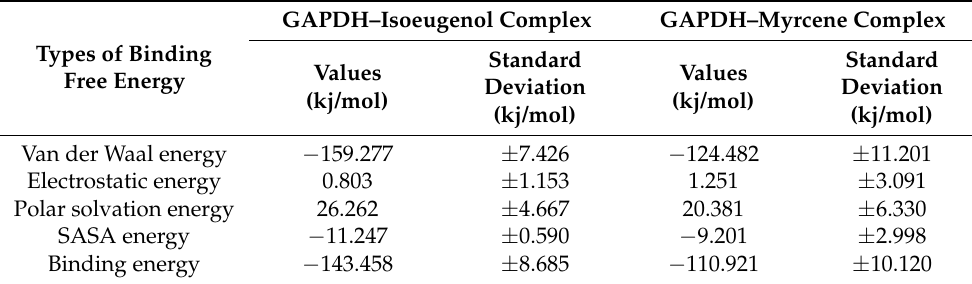
Table 6. Binding free energy calculations of protein–ligand